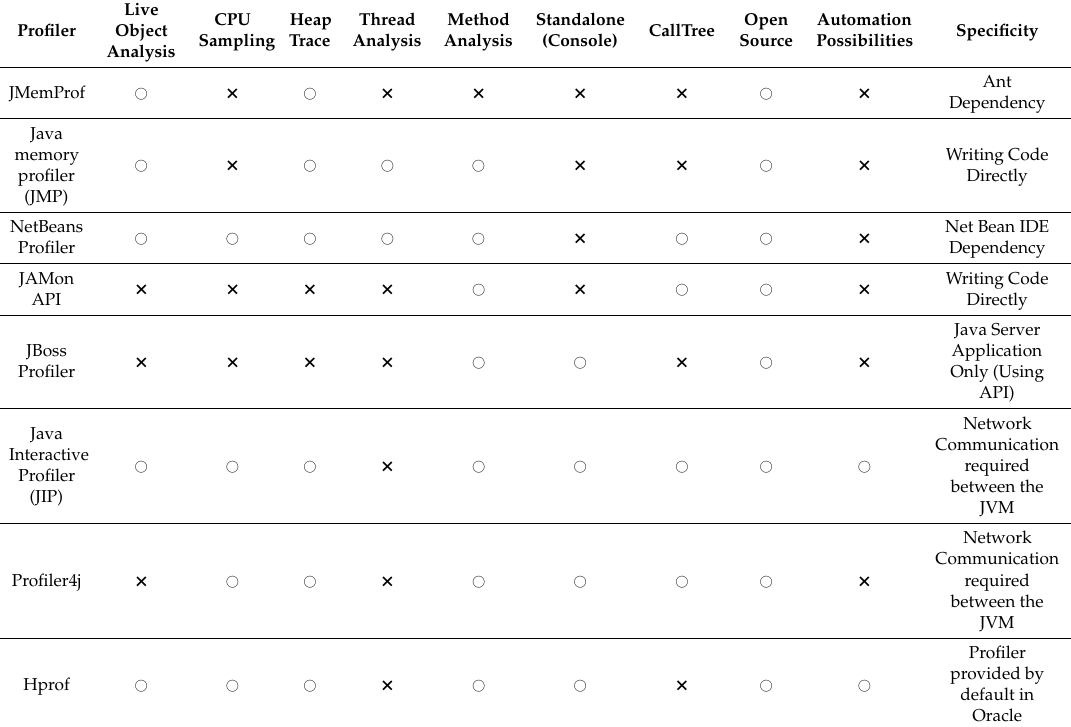
Table 2. Comparison of Java profilers. JVM, Java virtual